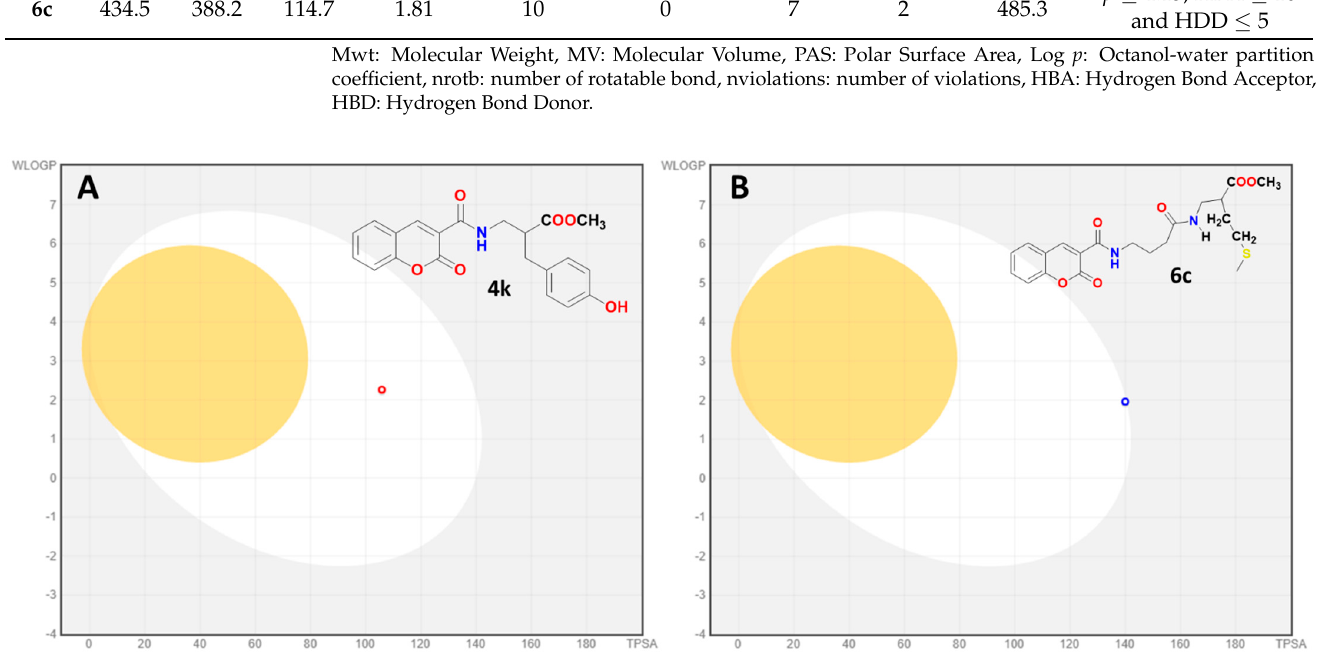
Figure 4. BOILED-Egg model for compounds 4k ( A ) and 6c ( B ) using the Swiss ADME. “Points located in the BOILED-Egg’s yolk are molecules predicted to passively permeate through the blood– brain barrier, while points located in the BOILED-Egg’s white are molecules predicted to be passively absorbed by gastrointestinal tract”.